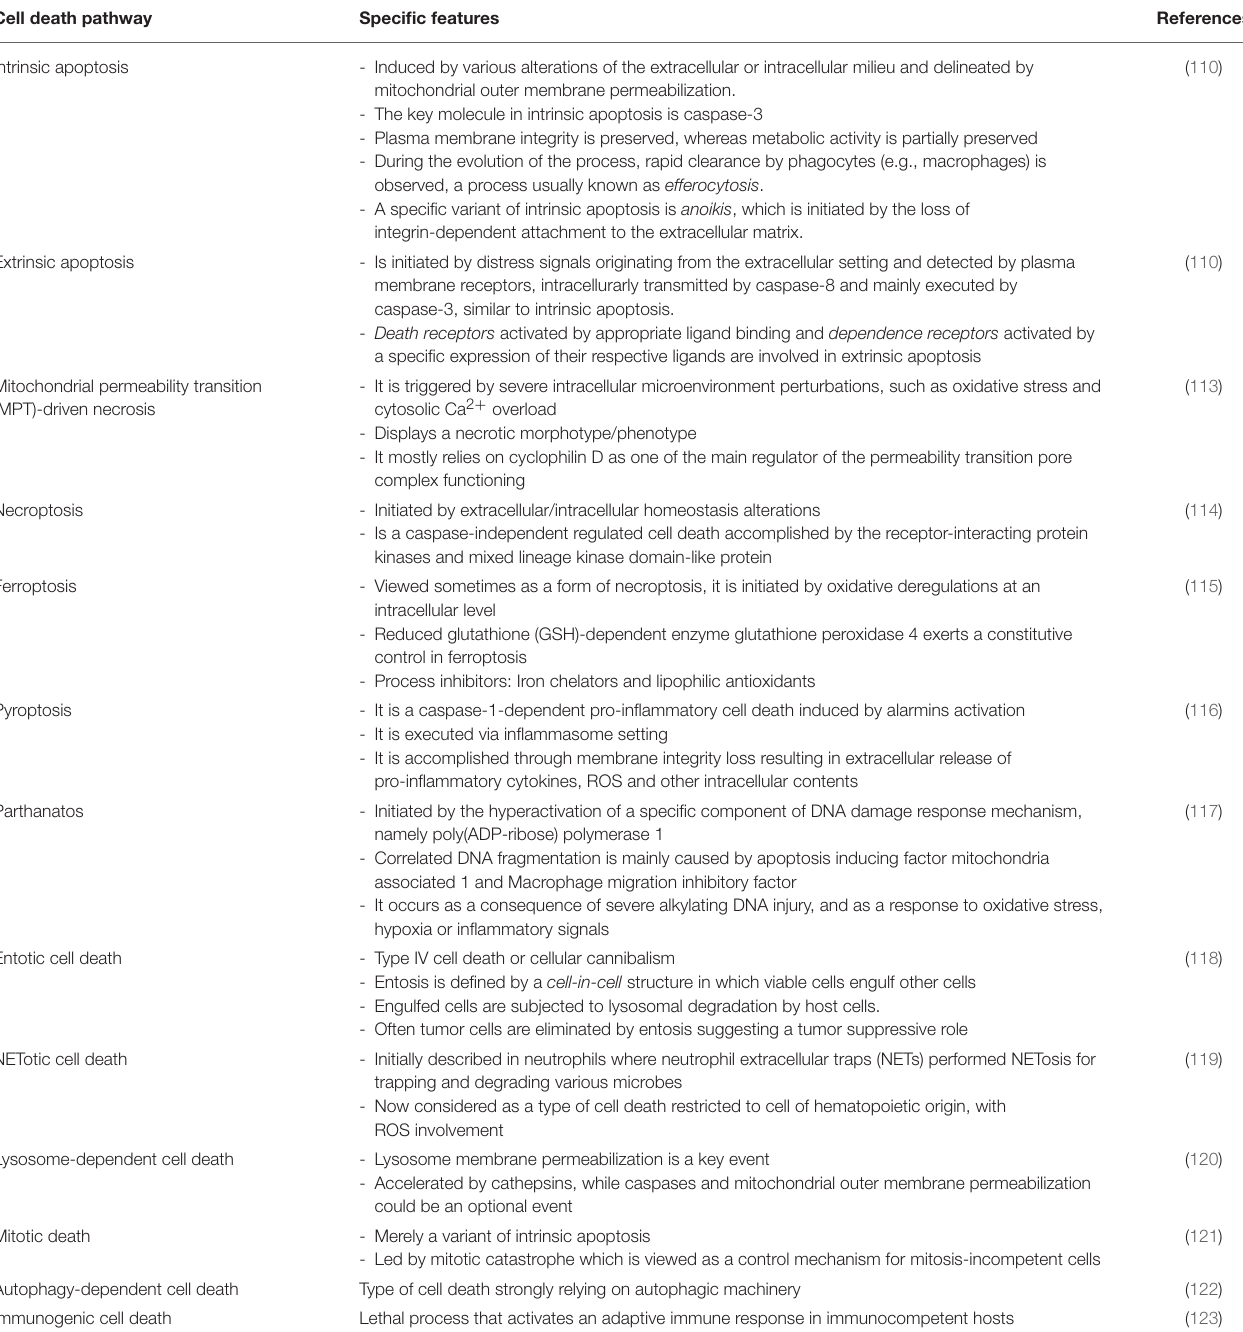
TABLE 1 | Main cellular death pathways and their characteristics. Cell death pathway Specific